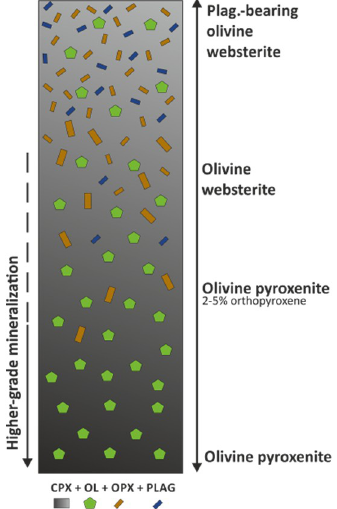
Figure 3. Schematic drawing showing gradational (i.e., no hard boundaries exist within an individual layer) mineralogical trends within the olivine pyroxenite magma layers that were earlier suggested to control the extent of the economic mineralization and form smaller-scale magmatic layering within the Kevitsa intrusion (modified from [21,22]). The layers were suggested to represent a spectrum of olivine pyroxenites consisting of plagioclase (PLAG) and orthopyroxene (OPX) rich tops (i.e., plagioclase-bearing olivine websterite) that grade into more olivine (OL) and clinopyroxene (CPX) rich bottoms (i.e., olivine pyroxenite). In this model, the mineralization is more strongly associated with the bases of the individual layers. The contacts between tops and bottoms of successive pulses were expected to be sharp. Typical thickness of one layers is tens to hundreds of meters.